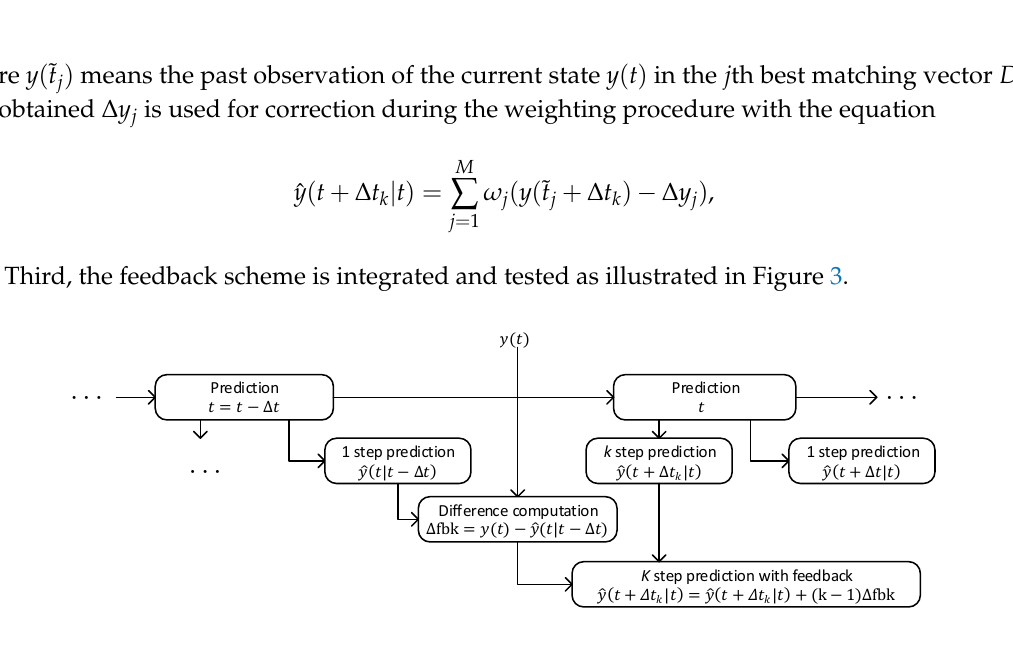
Figure 3. The feedback scheme integrated into Takens’ reconstruction-based methods.